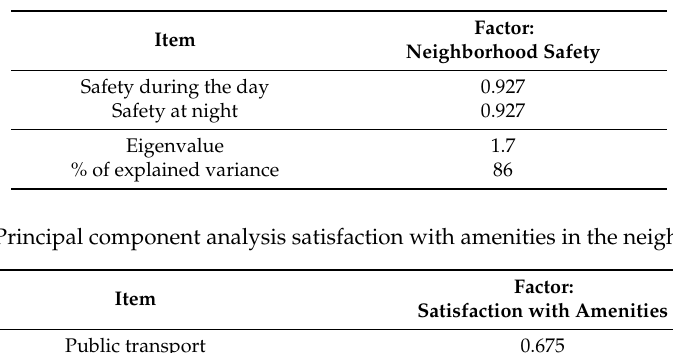
Table 5. Principal component analysis neighborhood safety.